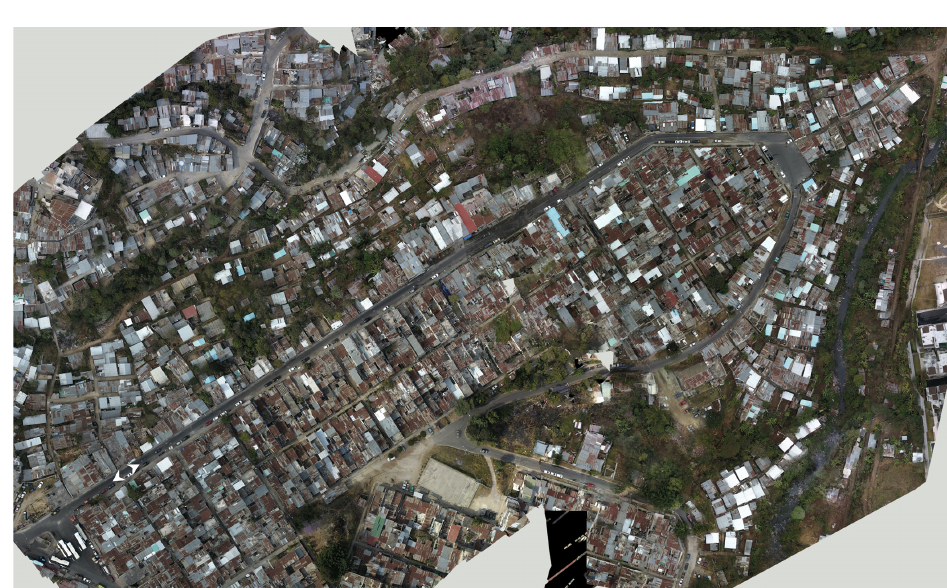
Figure 3. Orthophoto of Arzú, courtesy of